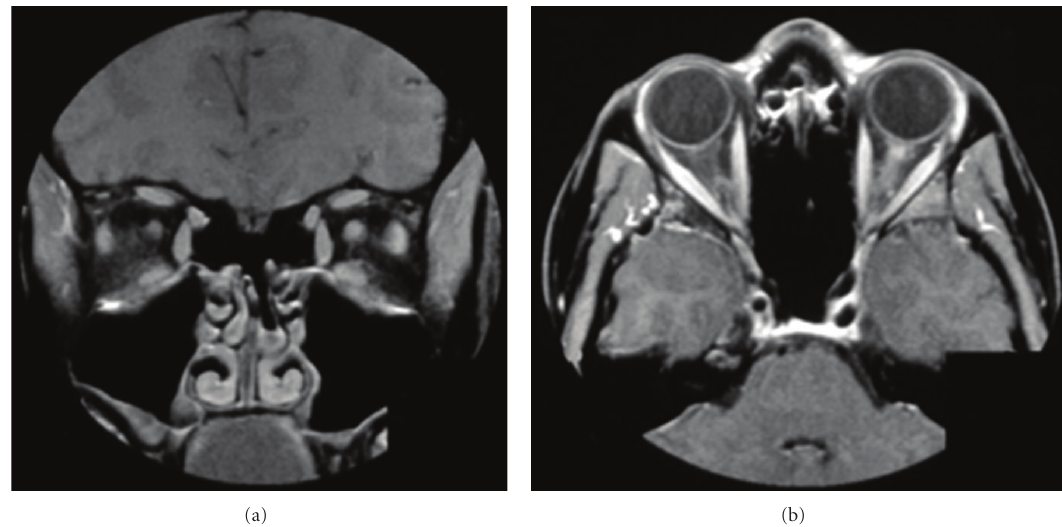
Figure 5: MR images of Case 6 showing gadolinium enhancement of the left optic nerve 24 hours after the onset of left retroorbital